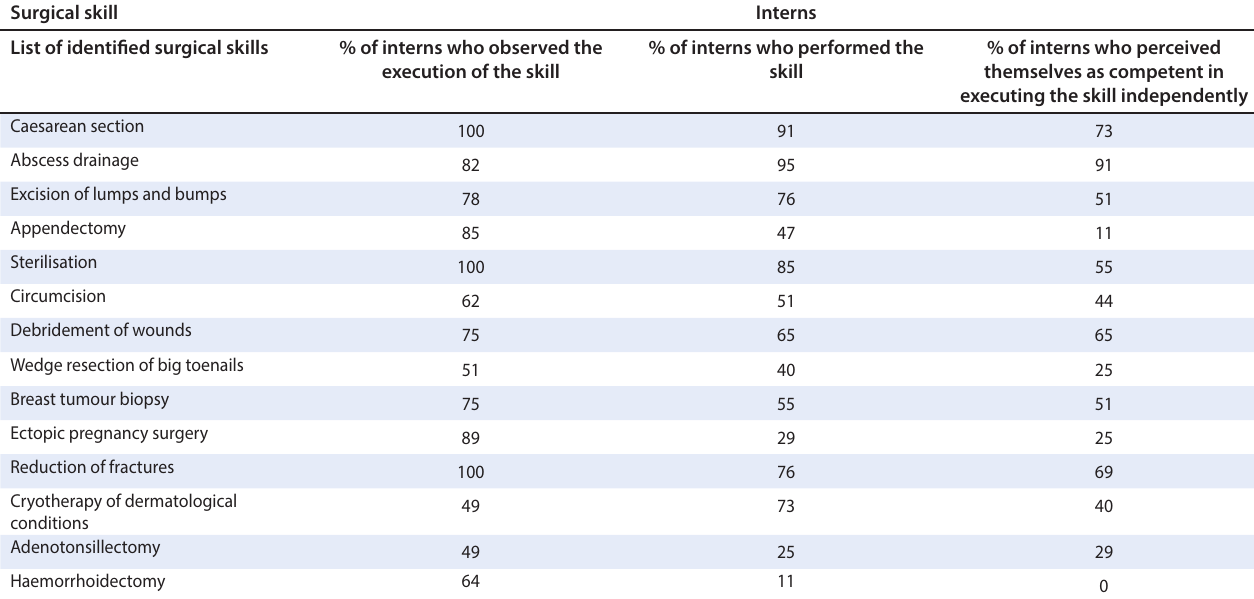
Table 2: Interns’ estimation of their competence in executing the core surgical skills Surgical skill Interns List of identified surgical